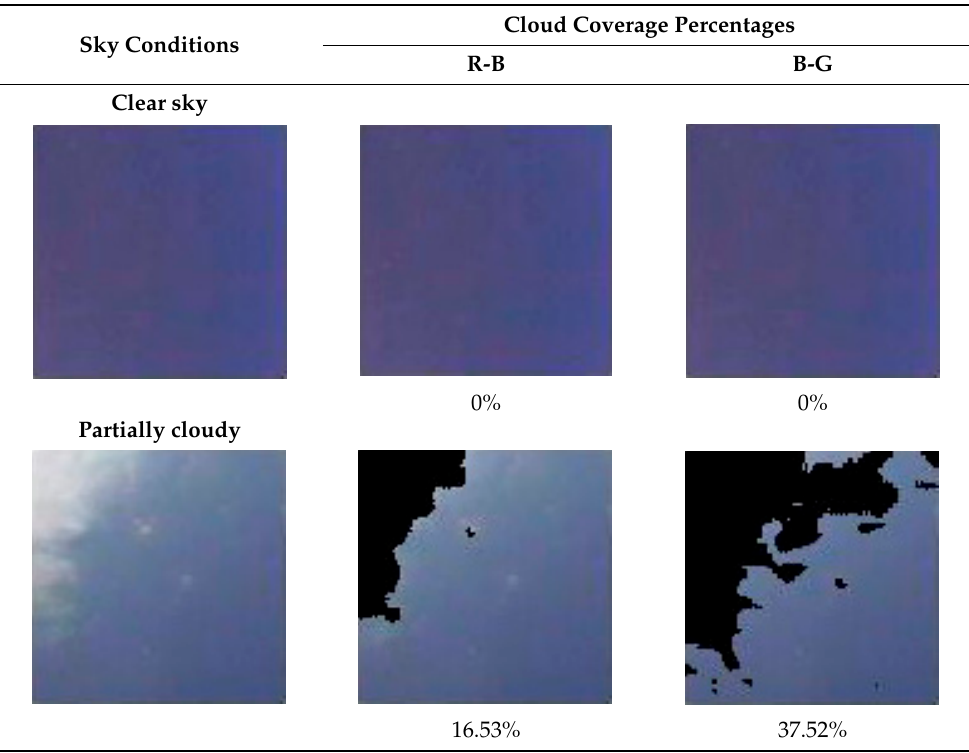
Table 3. Thin cloud detection and coverage percentage for B-G and R-B Color Difference .